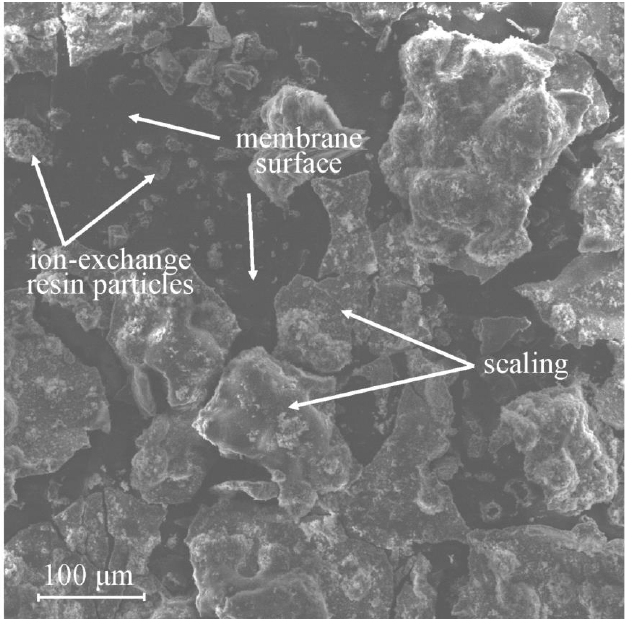
Figure 3. Scaling of the MA-41P membrane in a solution containing calcium and magnesium